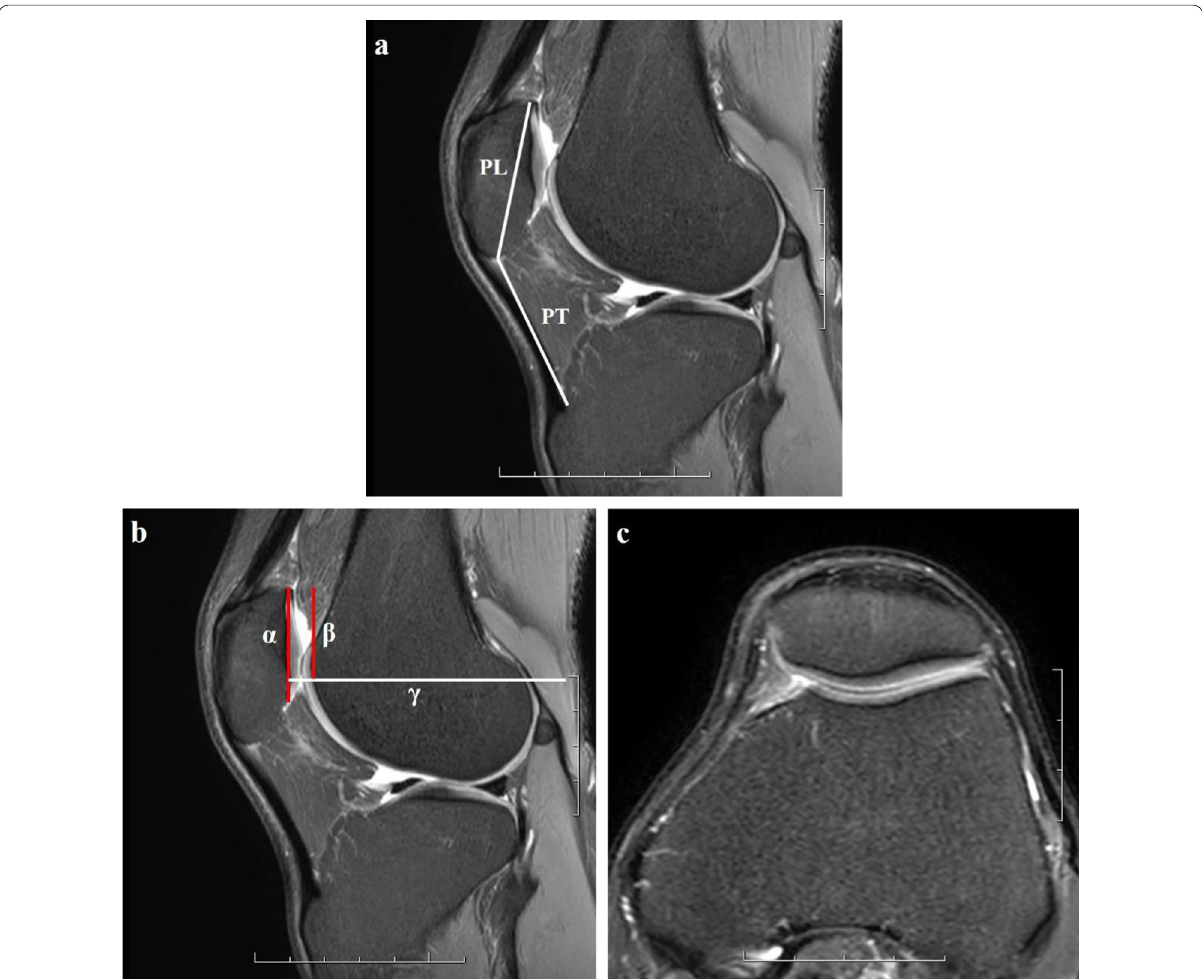
Fig. 4 Methods for determining the Insall–Salvati ratio ( a ) and SP-ET index ( b ), demonstration of measurements of the related parameters on sagittal MR images. a The Insall–Salvati ratio was calculated as the patellar tendon length (PT) divided by the maximum patellar diagonal length (PL); b the SP-ET index was calculated as the distance between the most superior point of patella and the entrance of femoral trochlea ( β ) divided by the patellar articular surface length ( α ). Line γ was the reference line of the entrance plane of femoral trochlea; c the entrance plane of femoral trochlea, and it was the first craniocaudal plane where the complete cartilaginous trochlea can be